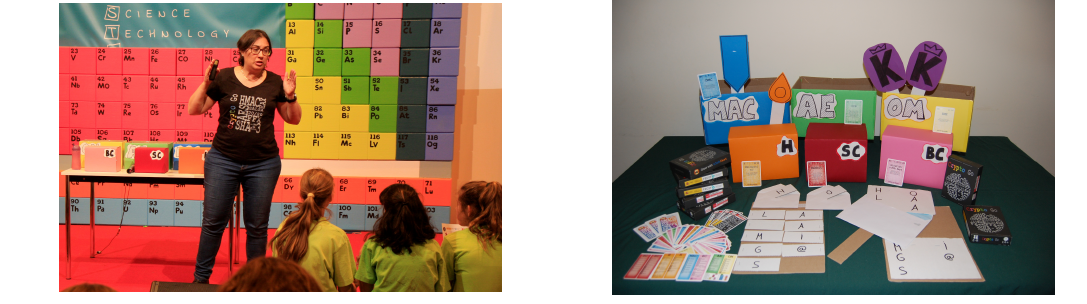
Figure 4. Workshops.